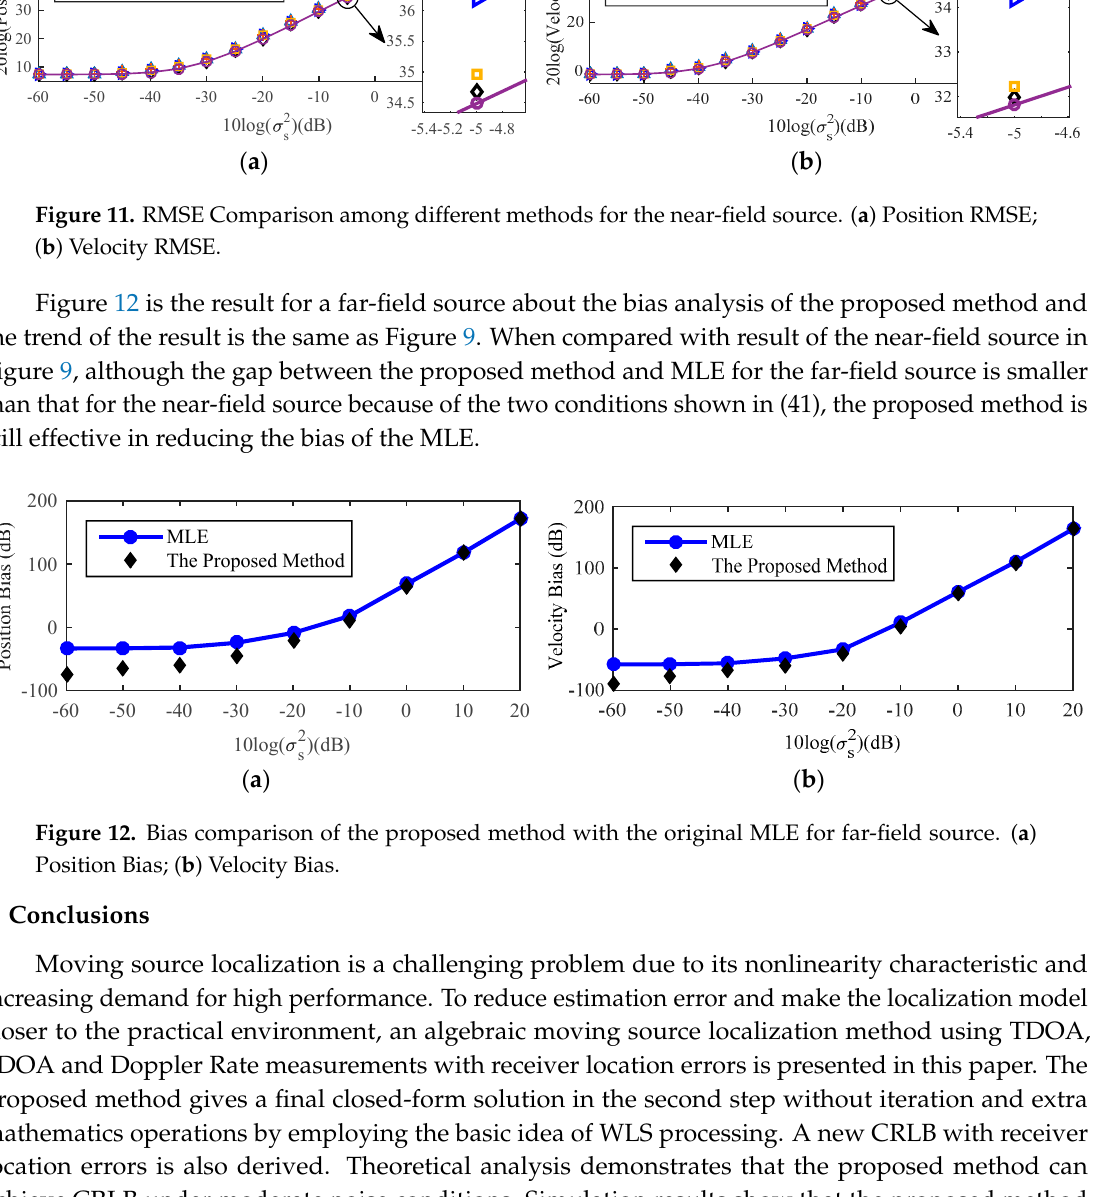
( b ) Velocity RMSE.